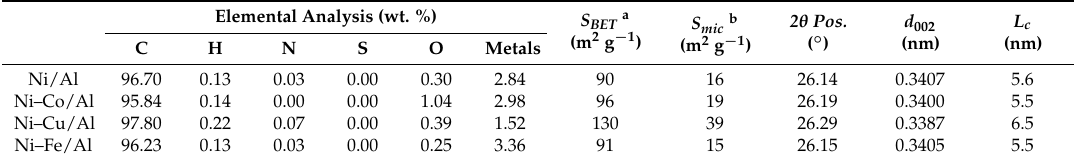
Table 1. Elemental composition and textural and structural parameters of the carbonaceous products.